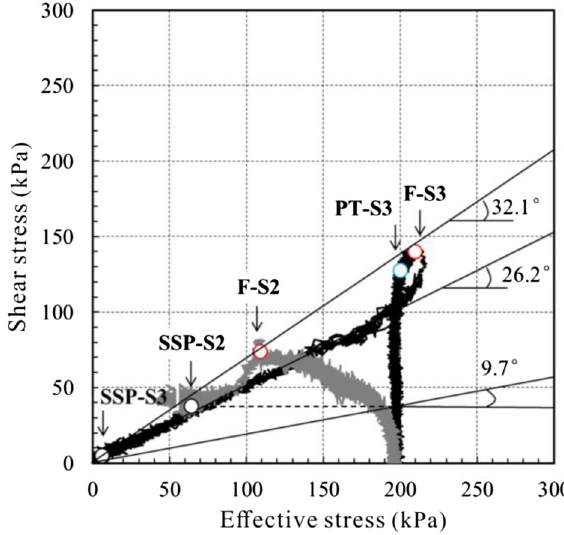
Figure 14. Effective stress paths of S2 and S3.